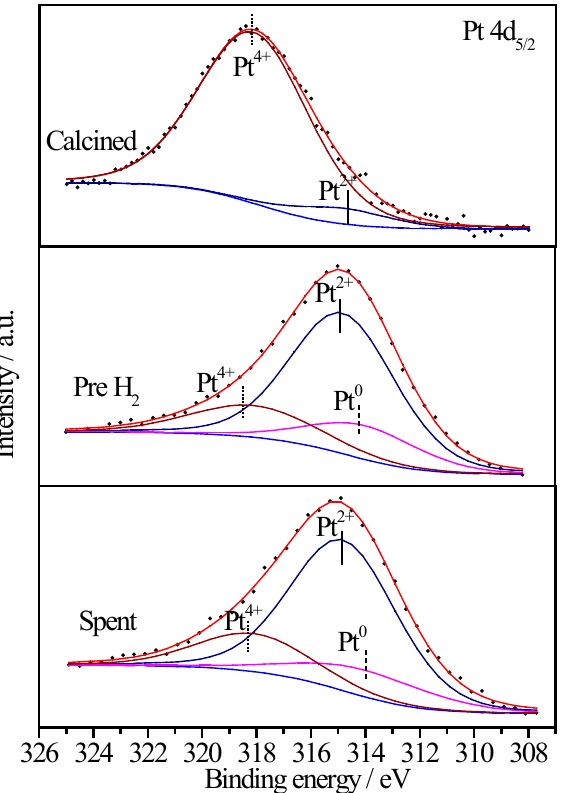
Figure 14. Pt-4d XPS spectra of the calcined, reduced, and spent Pt/CoO x /Al 2 O 3